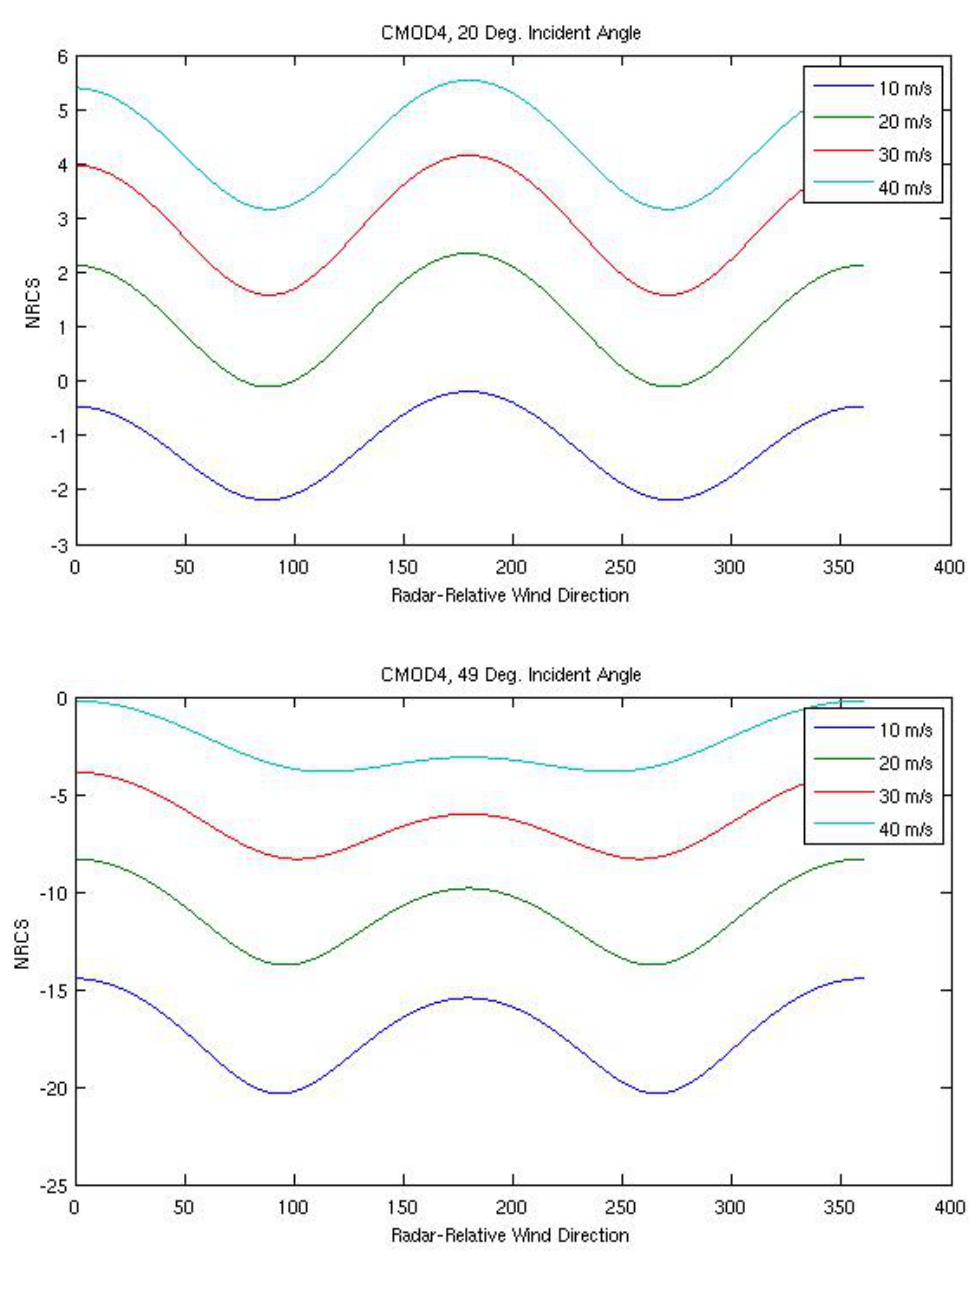
Figure 1. The relationship between NRCS, near-surface wind speed, and radar-relative near-surface wind direction for CMOD 4 and CMOD 5, continued on next